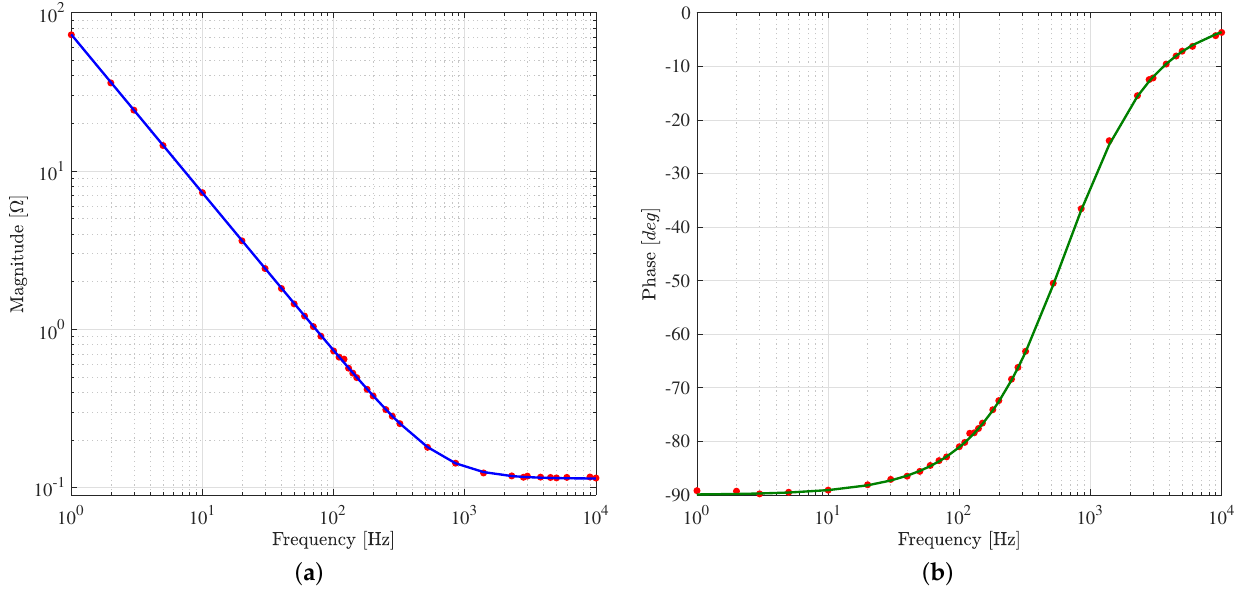
Figure 10. Multiple curve-fitting for magnitude and phase with MPPT OFF at 400 W/m 2 . ( a ) Magnitude. ( b )